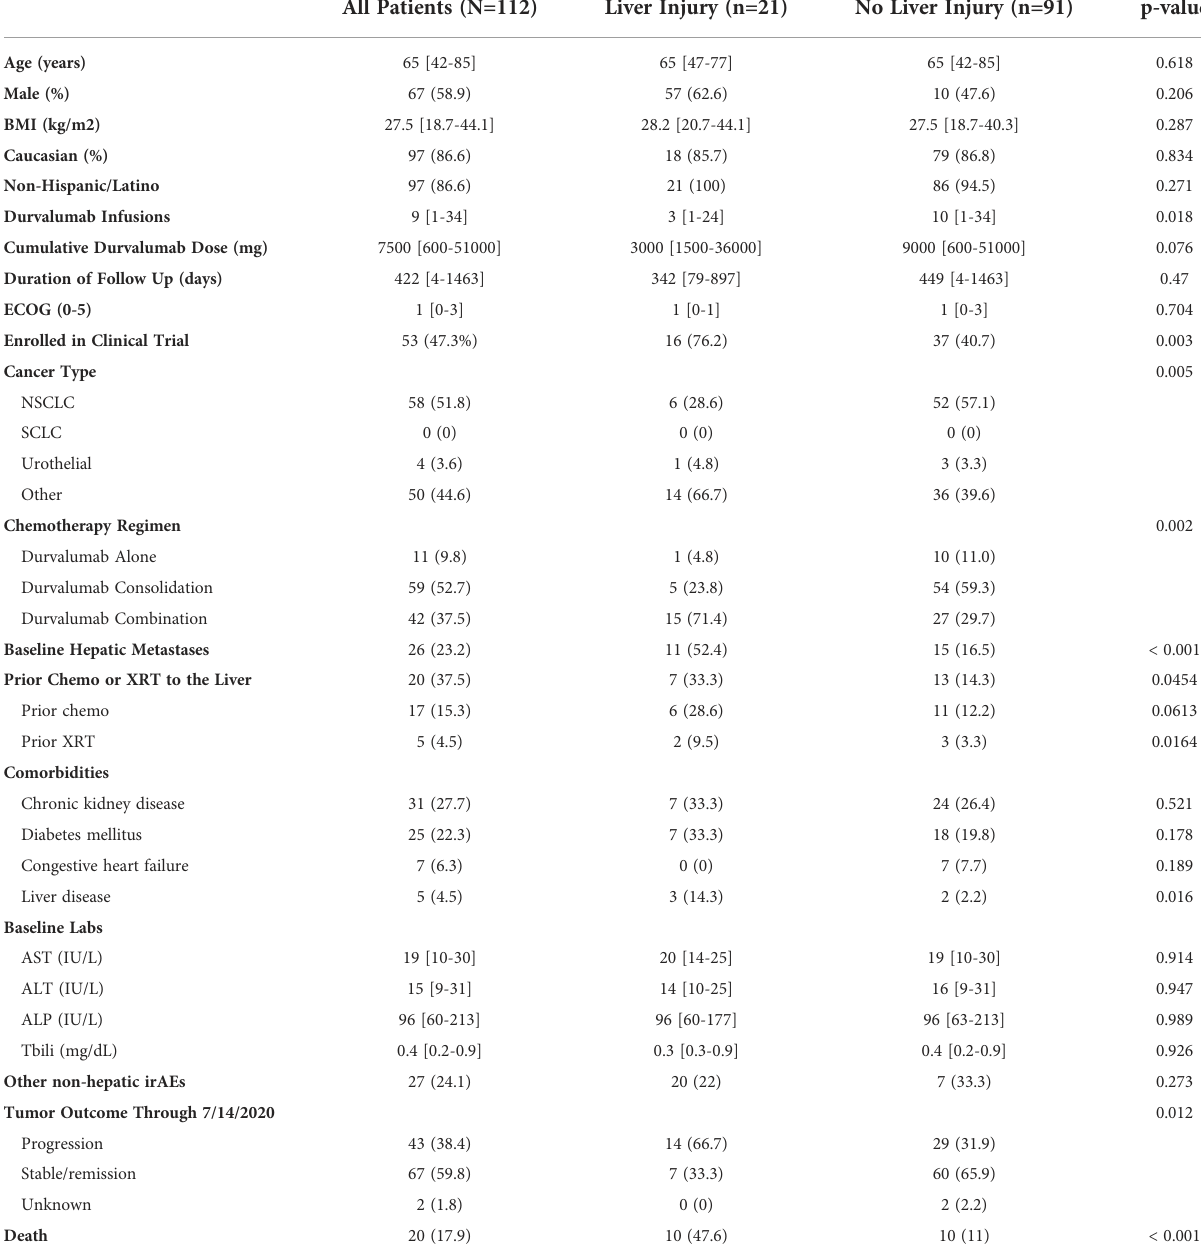
TABLE 1 Clinical characteristics of study